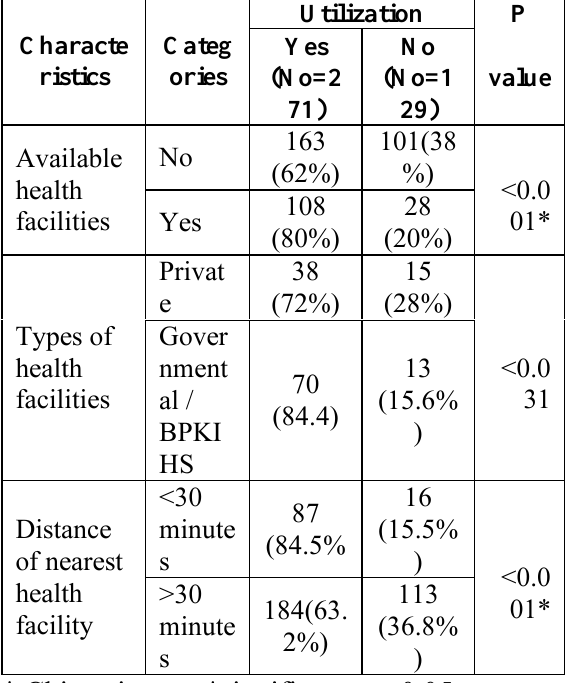
Table 6: Association between knowledge about availability of health facilities and health seeking